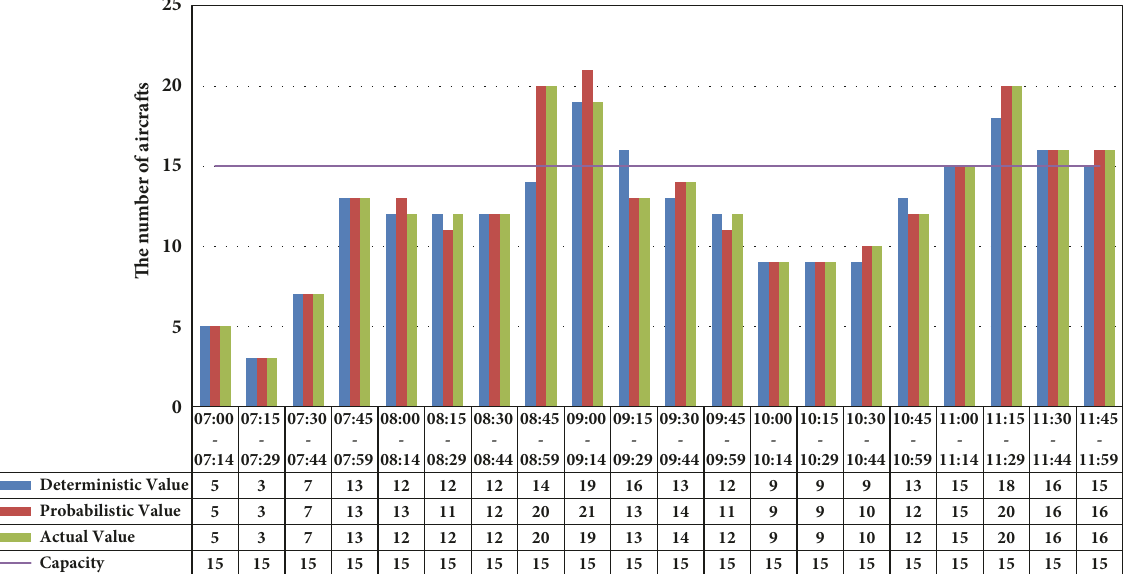
Figure 10: Comparison of the deterministic and probabilistic demand prediction results and comparison of the actual traffic flow value and capacity (Sector